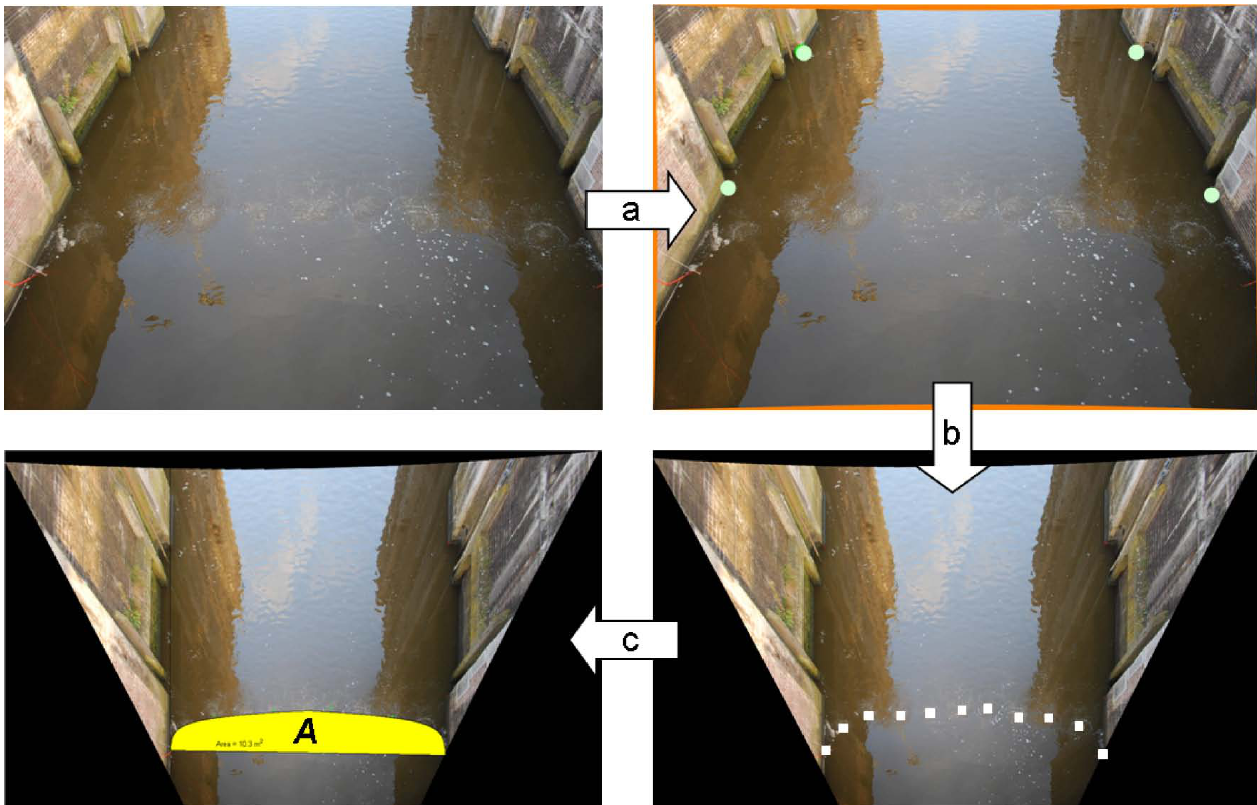
Fig. 6. Steps performed to process the image and obtain surface area A ; step (a) represents the correction for lens distortion, step (b) represents the 2-D reprojection of the image based on the four reference points on a horizontal plane (the light green circles), and step (c) finds the area in between the nozzle line and the bubble envelope (the white